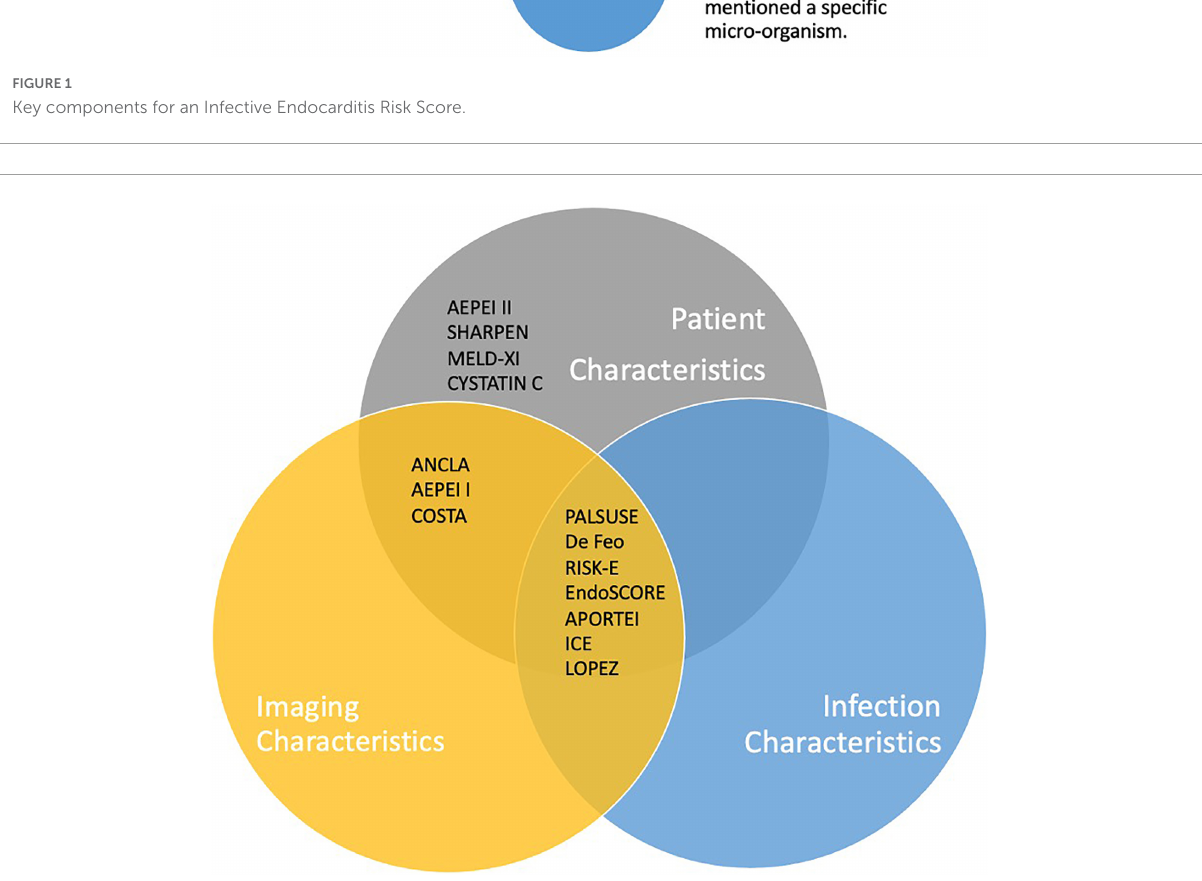
FIGURE2 Inclusion of key criteria in IE-specific risk scores currently